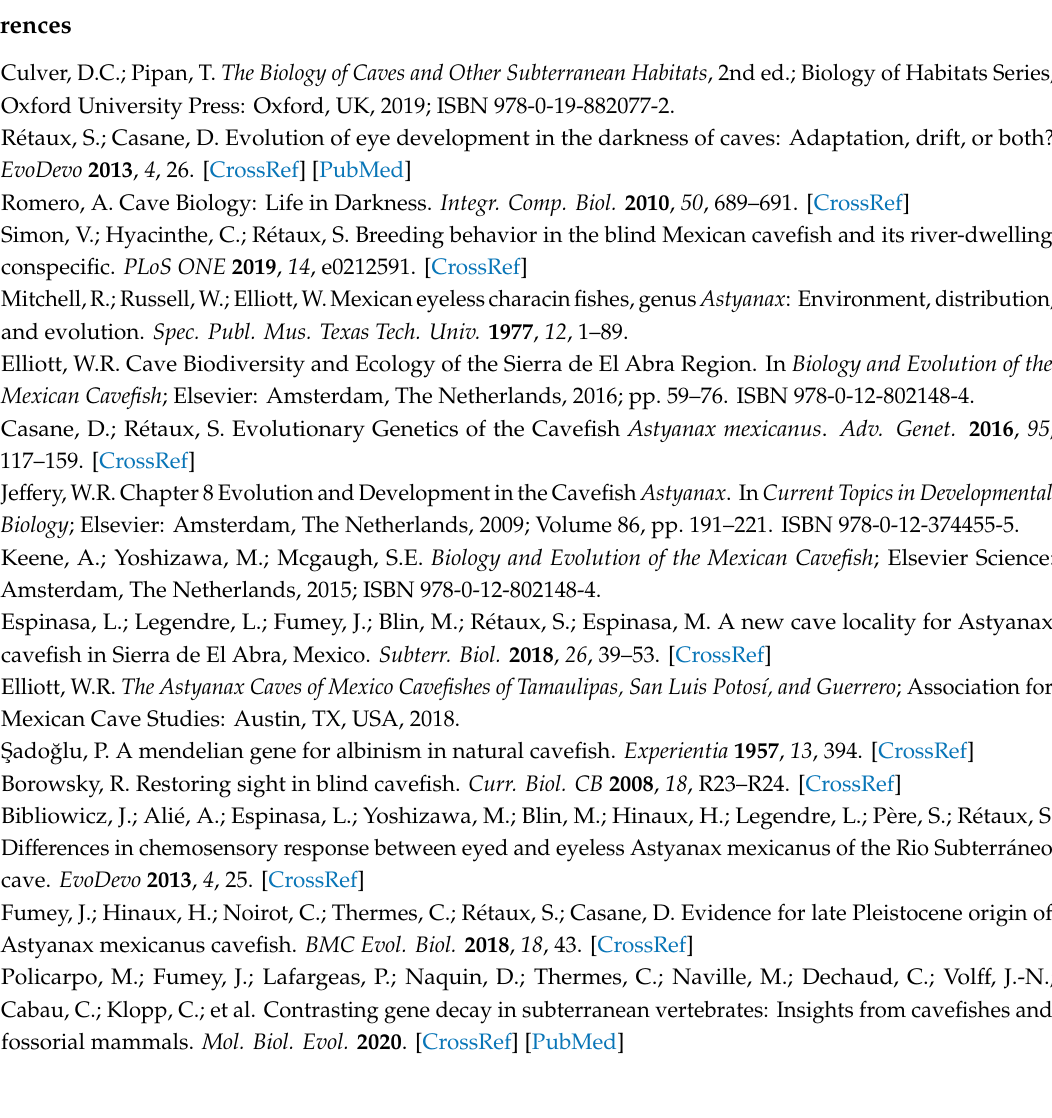
Figure S1: Rationale for olfactory scoring. Figure S2: Place preference problem in the Sabinos cave. Video S1: Behavioral response of Pach ó n cavefish to chondroitin in laboratory settings. Video S2: Behavioral response of Pach ó n cavefish to chondroitin in natural